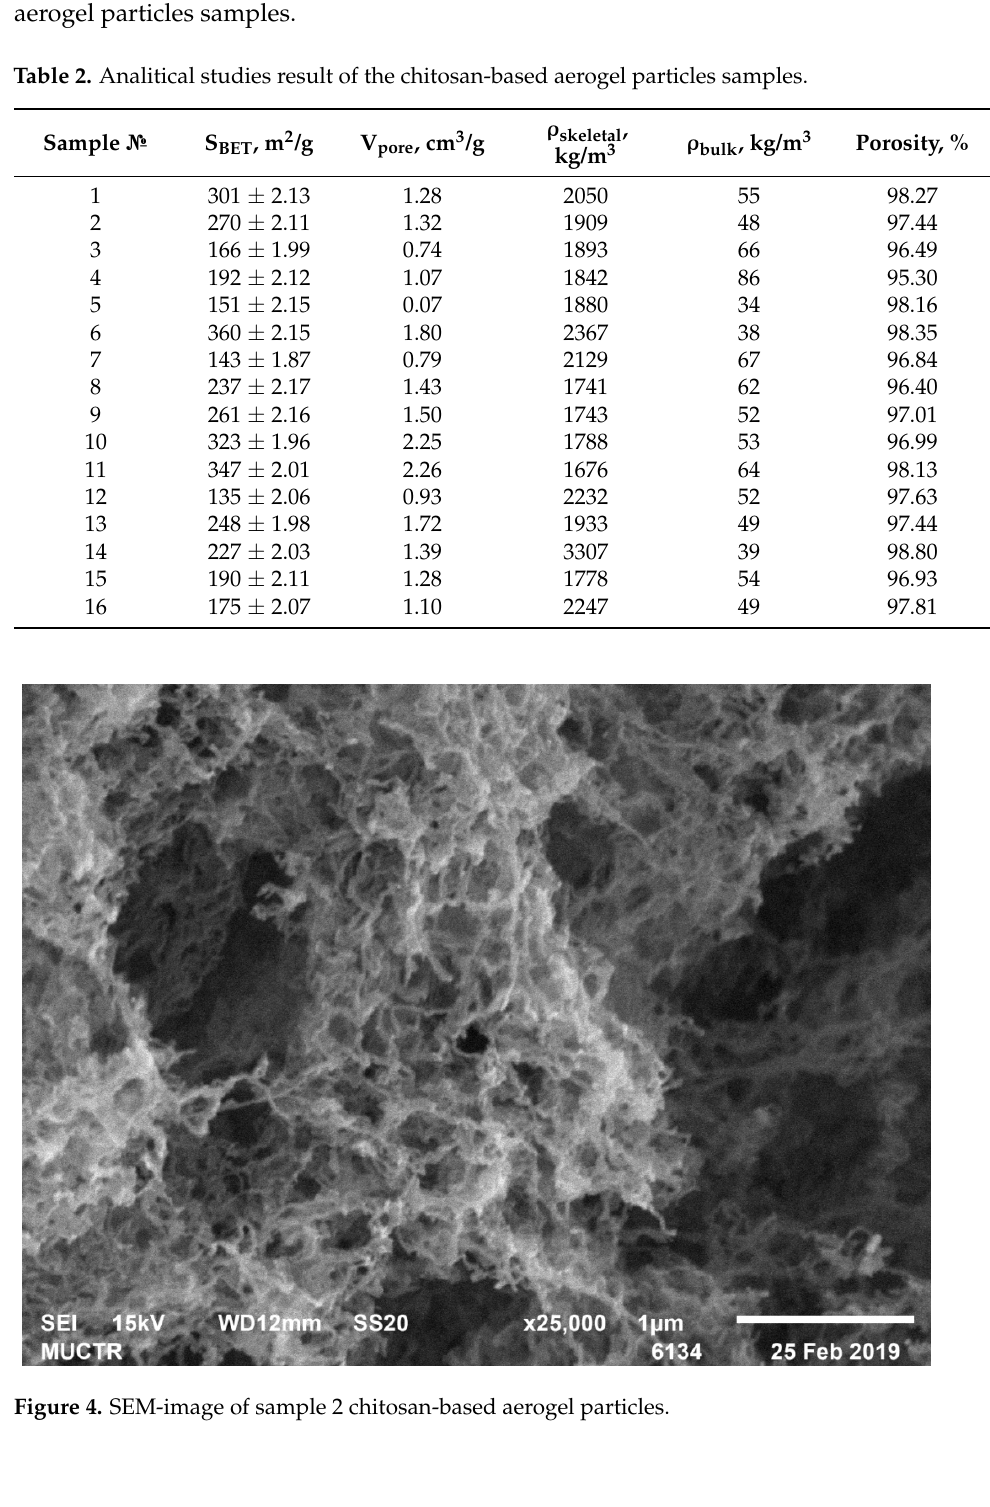
Figure 5. SEM-image of sample 3 chitosan-based aerogel particles.